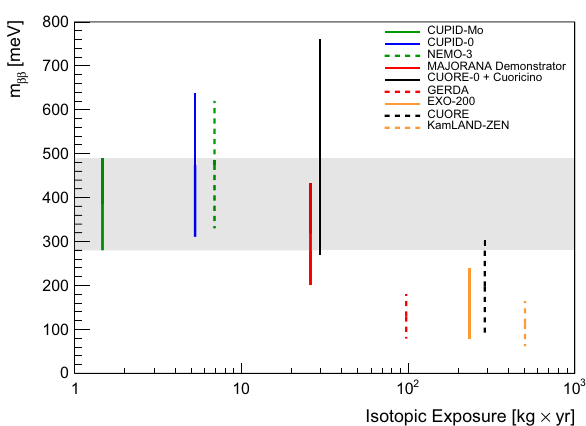
Fig. 15 The unblinded background spectrum near the ROI for 2.71 kg × year of data (1.47 kg × year for 100 Mo). After application of all cuts we observe no events in both the ROI and in the full 100 keV blinded region. In this work, the event near 3200 keV present in the pre- vious analysis [19], was tagged as coincident with the improved muon veto. The exposure weighted mean ROI (17.12 keV) is shown with dashed lines, and the full blinded region is within the solid lines